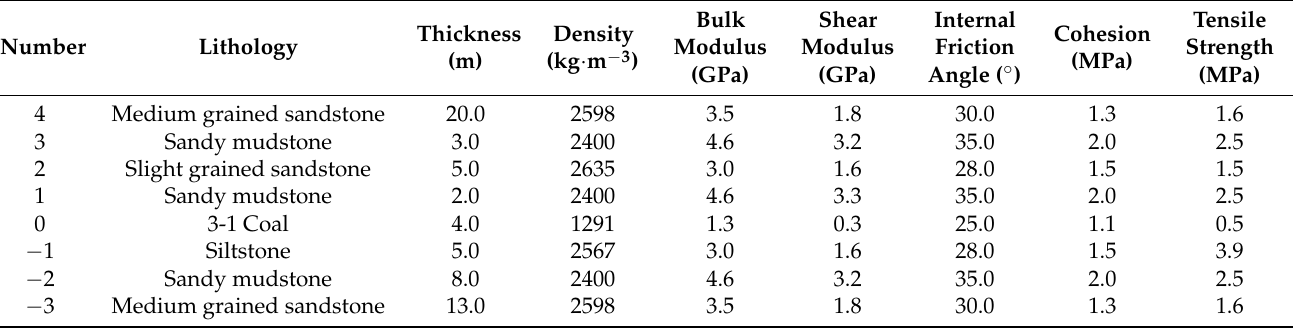
Table 1. The Mohr-Coulomb criterion is adopted for operation calculation. Table 1. Rock occurrence and mechanical